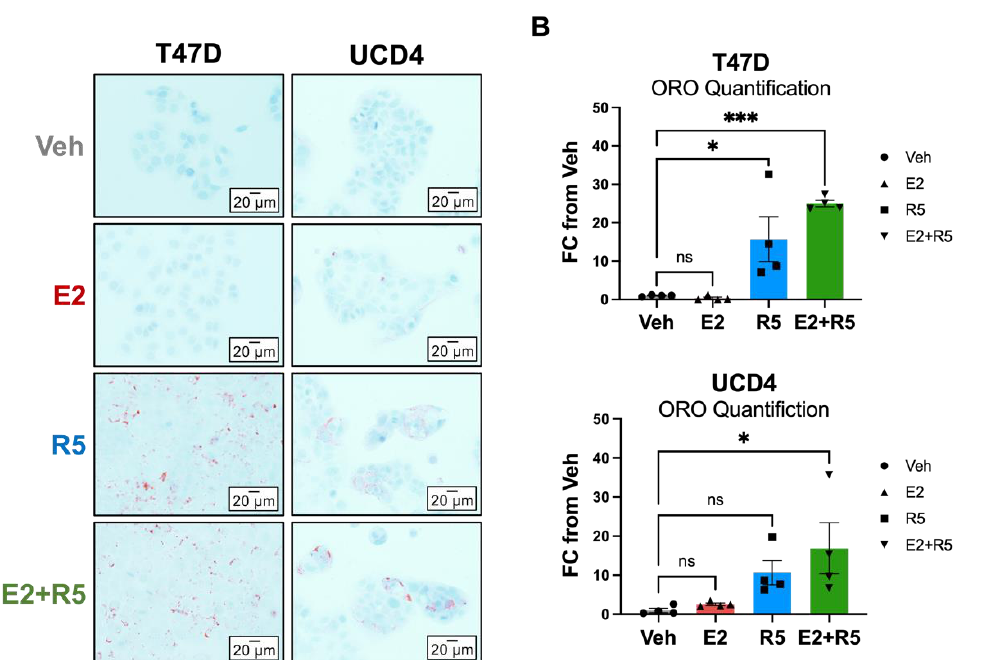
Figure 6. Progestins activate glycerolipid metabolism in breast cancer cell lines. ( A ) Oil Red O (ORO) neutral lipid staining of fixed T47D and UCD4 cells treated with estradiol (E2, 10 −8 M), promegestone (R5, 10 −8 M), combination (E2 + R5, 10 −8 M each), or ethanol (Veh) for 5 days. ( B ) ORO quantification conducted in ImageJ, normalized to cell area, and fold change (FC) compared against vehicle. Four fields were used per treatment condition. * p < 0.05, *** p < 0.001, ns = not significant.